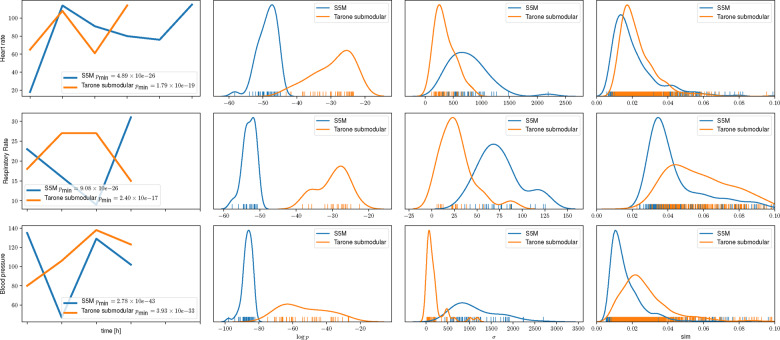
Comparing the extraction of representative and statistically significant shapelets associated with Sepsis in MIMIC-III with S5M and the two-step approach Tarone submodular. Each row refers to one clinical variable (heart rate, respiratory rate and systolic blood pressure). In the first column, the shapelet returned by S5M/Tarone submodular with the lowest P-value is depicted. Note that the particular date at which a shapelet occurs within a time series has no associated biological meaning, leaving the x-axis ticks blank. The second column shows the distribution of the shapelet P-values (on a log ⁡P-scale). In the third column, the structural diversity of the set of shapelets is shown by assessing the distribution of within-shapelet variances. The fourth column displays the distribution over the pairwise shapelet similarities. We observe that S5M returns a structurally more diverse set of shapelets with on average lower P-values including the shapelet with the lowest P-value, which was not deemed representative in Tarone submodular